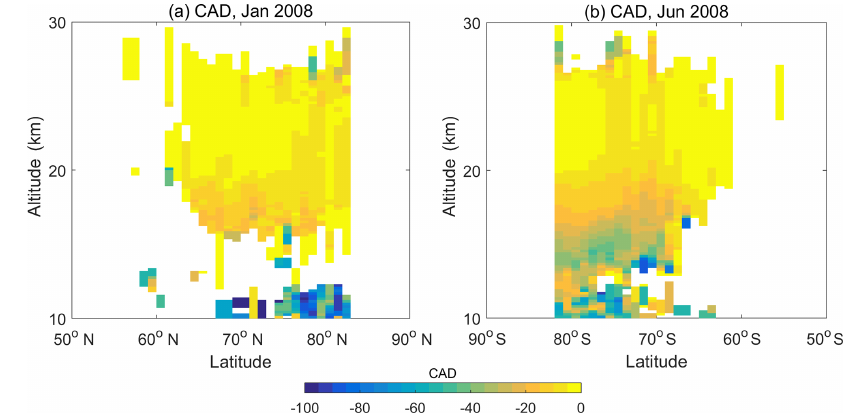
Figure 22. Spatial distributions of the CAD scores for polar stratospheric aerosols in (a) January and (b) June 2008.